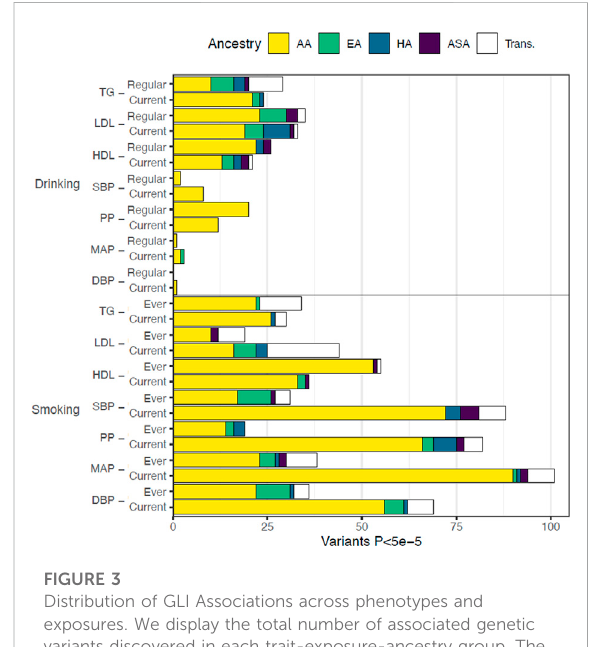
FIGURE 3 Distribution of GLI Associations across phenotypes and exposures. We display the total number of associated genetic variants discovered in each trait-exposure-ancestry group. The associations in models utilizing alcohol-related exposures are shown inthetop fi gure and represent the minorityof observed associations. The alcohol-related associates were dominated by analyses studying blood lipids. The associations related to cigarette smoking exposure are shown in the bottom fi gure with the majority of observations among analyses of blood pressure